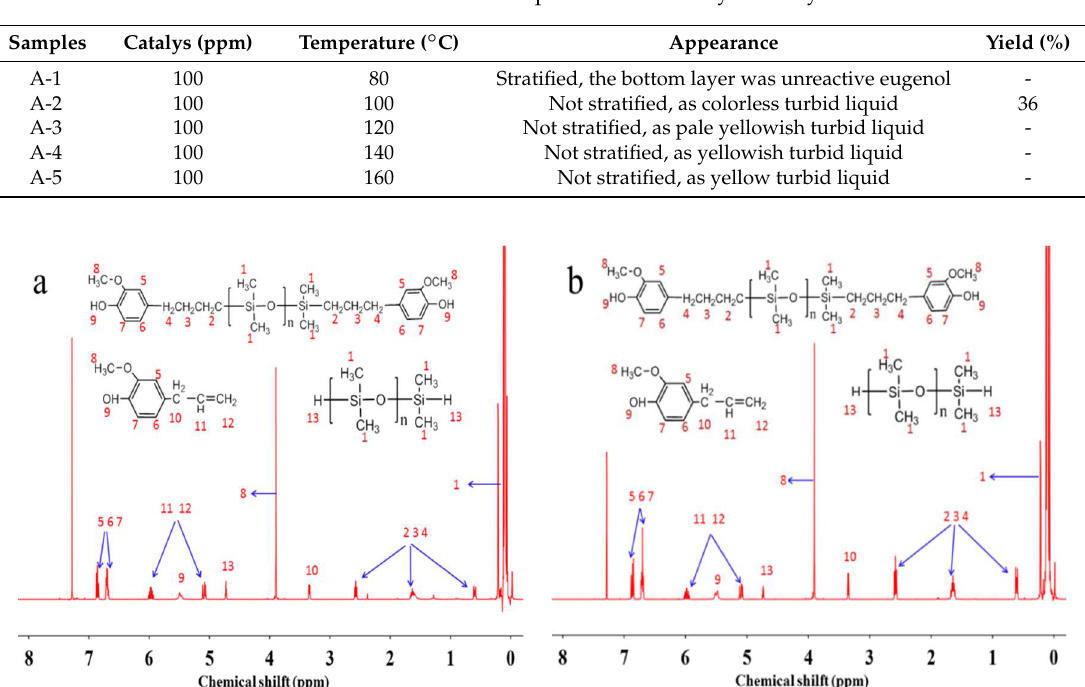
Table 1. Effect of reaction temperature on activity of catalyst.